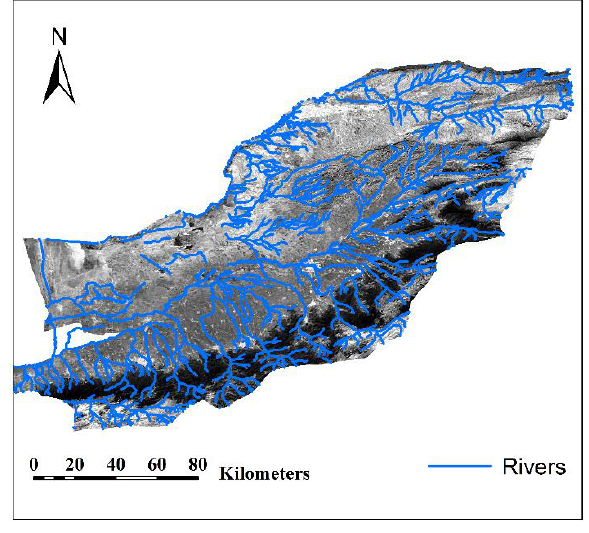
Figure 3 . Rivers data